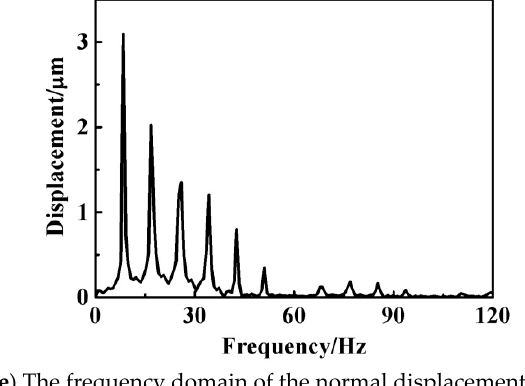
Figure 14. The service performances of the